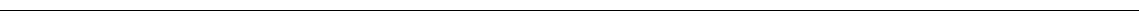
Fig. 1 Cloning of Sc reveals variations in genomic structure and copy number. a Pollen phenotypes of T65, E5, and their F 1 . Arrows indicate smaller, sterile pollen grains (scale bars, 50 μ m). The self-fertilized F 2 family shows a severely distorted segregation of the alleles ( P < 0.001 for the chi-square test). b Fine-mapping of Sc using F 2 plants of the T65/E5 cross. The markers indicate the positions (kb) in the BAC of the japonica cultivar (cv) Nipponbare (Nip). c Genomic con fi gurations of the Sc alleles in japonica lines (from GenBank except for T65) and indica lines (determined in this study). The Sc-i allele variants have three or two tandemly duplicated segments, each containing the gene homologous to Os03g0247300 . T1 (2016 bp) and T2 (9087 bp) are transposon insertions (a DDE-type and a Rim2/Hipa-type, respectively). The Sc-i paralogous genes have recombinant promoter/upstream sequences different from that of Sc-j . d Fiber-FISH images of the MH63 BAC (~ 180 kb) and the E5 chromatin (genomic) DNA (gDNA). For the BAC fi ber-FISH, Probes I and II were labeled for red fl uorescence, and the whole BAC DNA was labeled for green fl uorescence. The labeled Probe I (or Probe II) was mixed with the labeled BAC for the hybridization. For fi ber-FISH of E5 gDNA, Probes I and II were labeled for red and green fl uorescence, respectively, and mixed for hybridization. Scale bars, 2 μ m. Note that the BAC and chromatin DNA fi bers for the same segments had different extension levels, similar to the